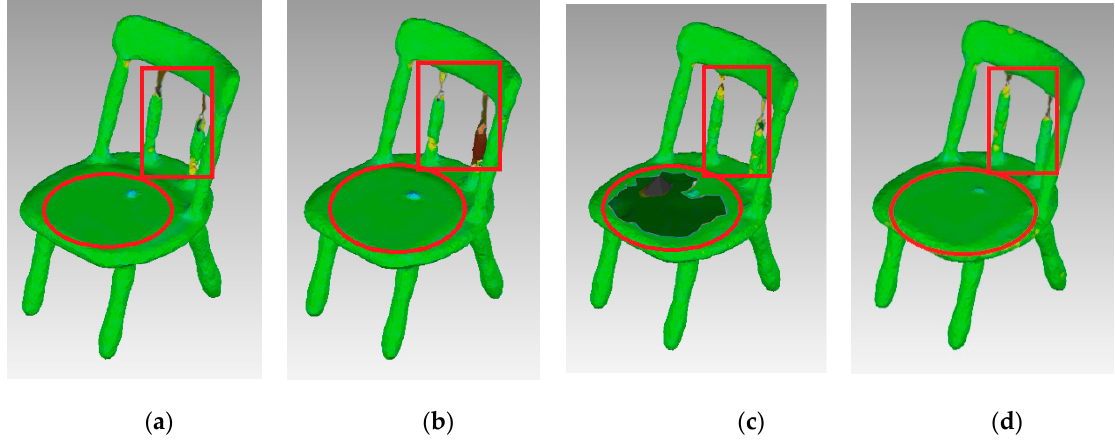
Figure 17. Simplification effect comparison of four simplification algorithms using the Chair data set: ( a ) uniform-based simplification algorithm; ( b ) grid-based simplification algorithm; ( c ) curvature-based simplification algorithm; ( d ) FPPS.